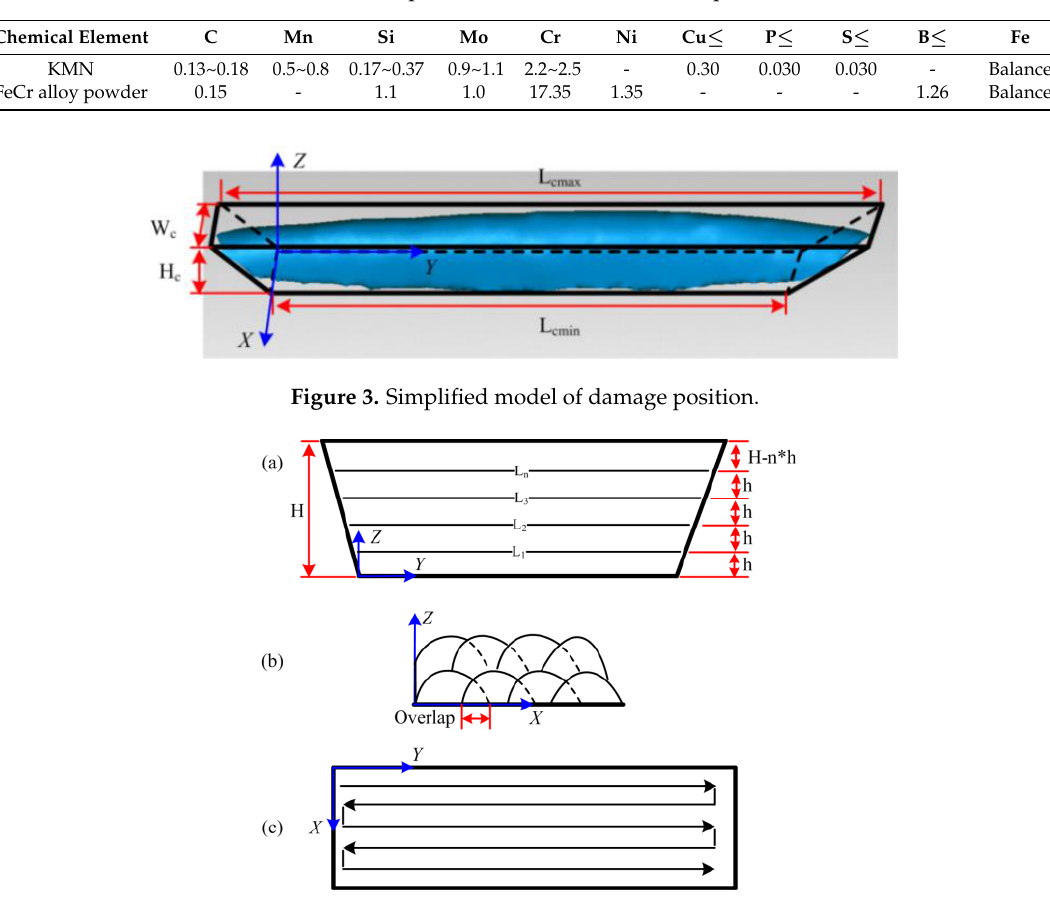
Figure 4. Schematic diagram of slicing and path planning: ( a ) slice planning; ( b ) overlapping rate; ( c ) scanning path.